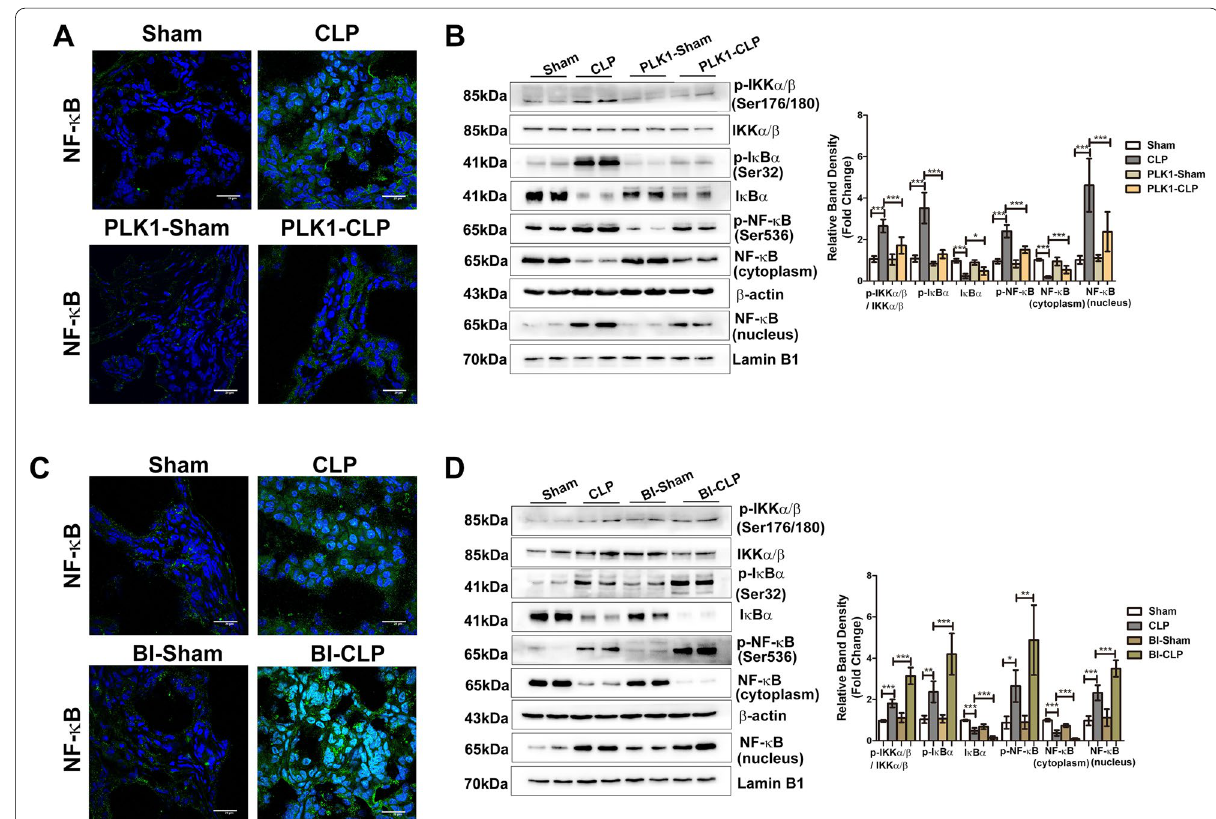
Fig. 4 PLK1 negatively regulates the activity of NF‑κB signalling in the intestine during sepsis. A , C The localization of NF‑κB was examined after the indicated treatments. NF‑κB is stained green; the nuclei are stained blue. The scale bar represents 20 μm. B , D Representative Western blots showing the indicated proteins in the NF‑κB pathway are on the left, and the graph on the right shows the relative band densities. The data in the graphs are expressed as the mean SD. * P < 0.05, ** P < 0.01, *** P < 0.001. (n ± =